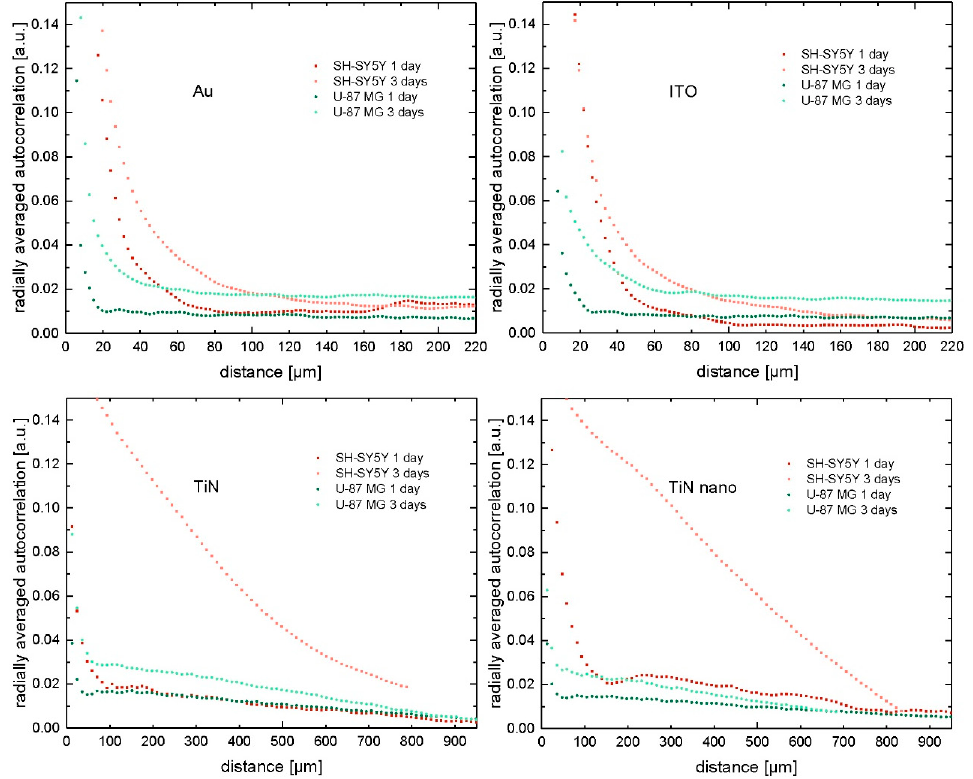
Figure 3. Radially averaged autocorrelation analysis for cell nuclei positions obtained from 12 individual experiments with U-87 MG cells (green) and SH-SY5Y cells (red) cultured on different materials.